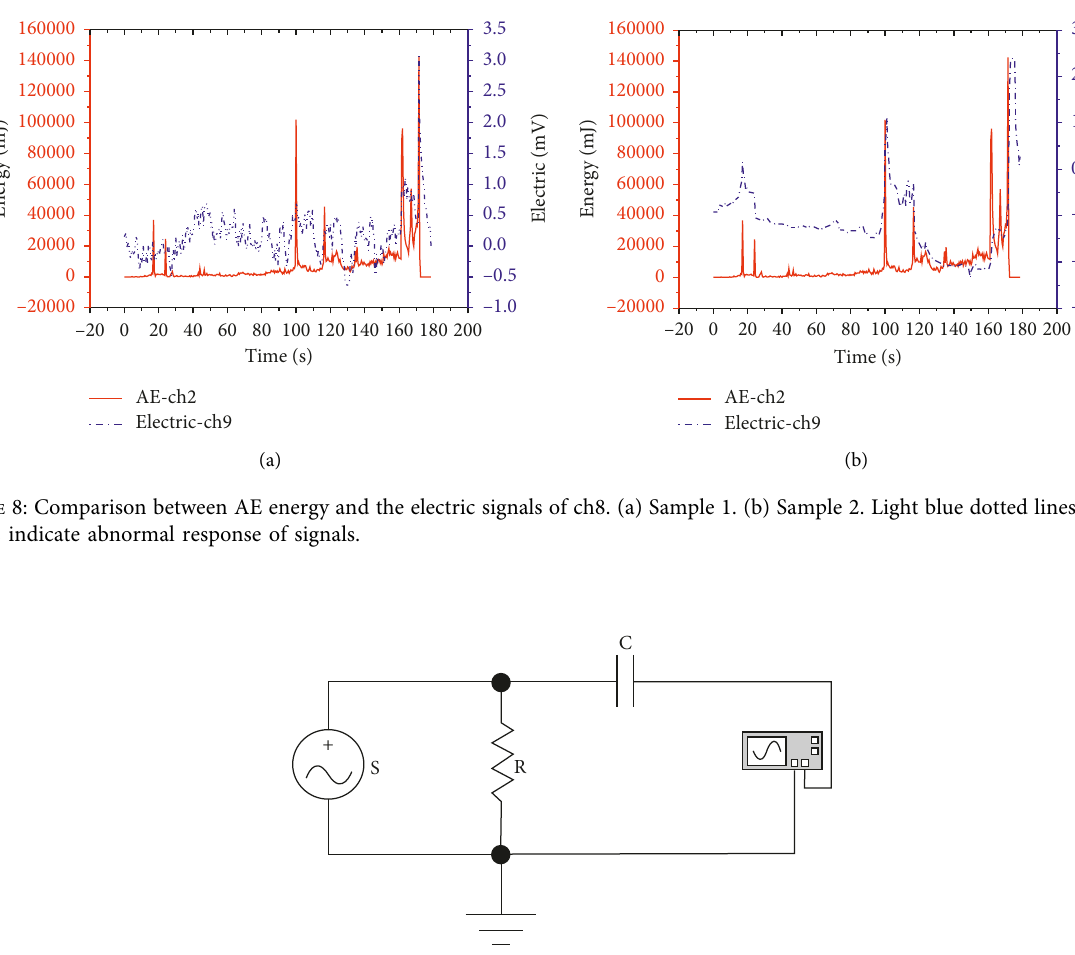
Figure 9: Acoustic-electric coupling